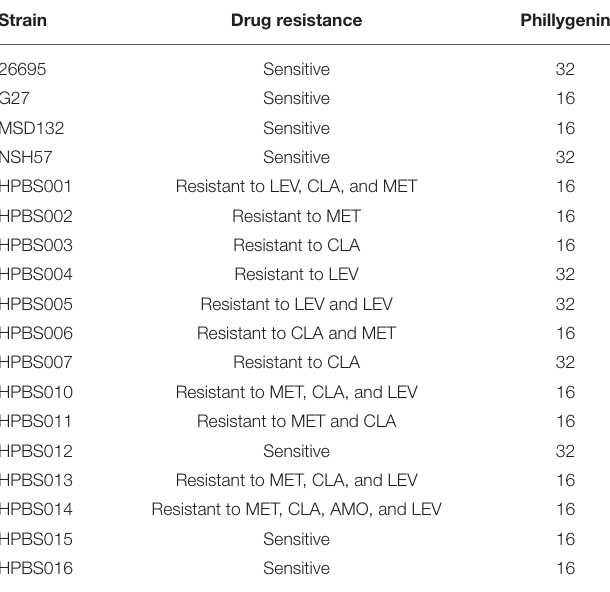
TABLE 2 | The MICs of phillygenin against H. pylori ( µ g/ml).